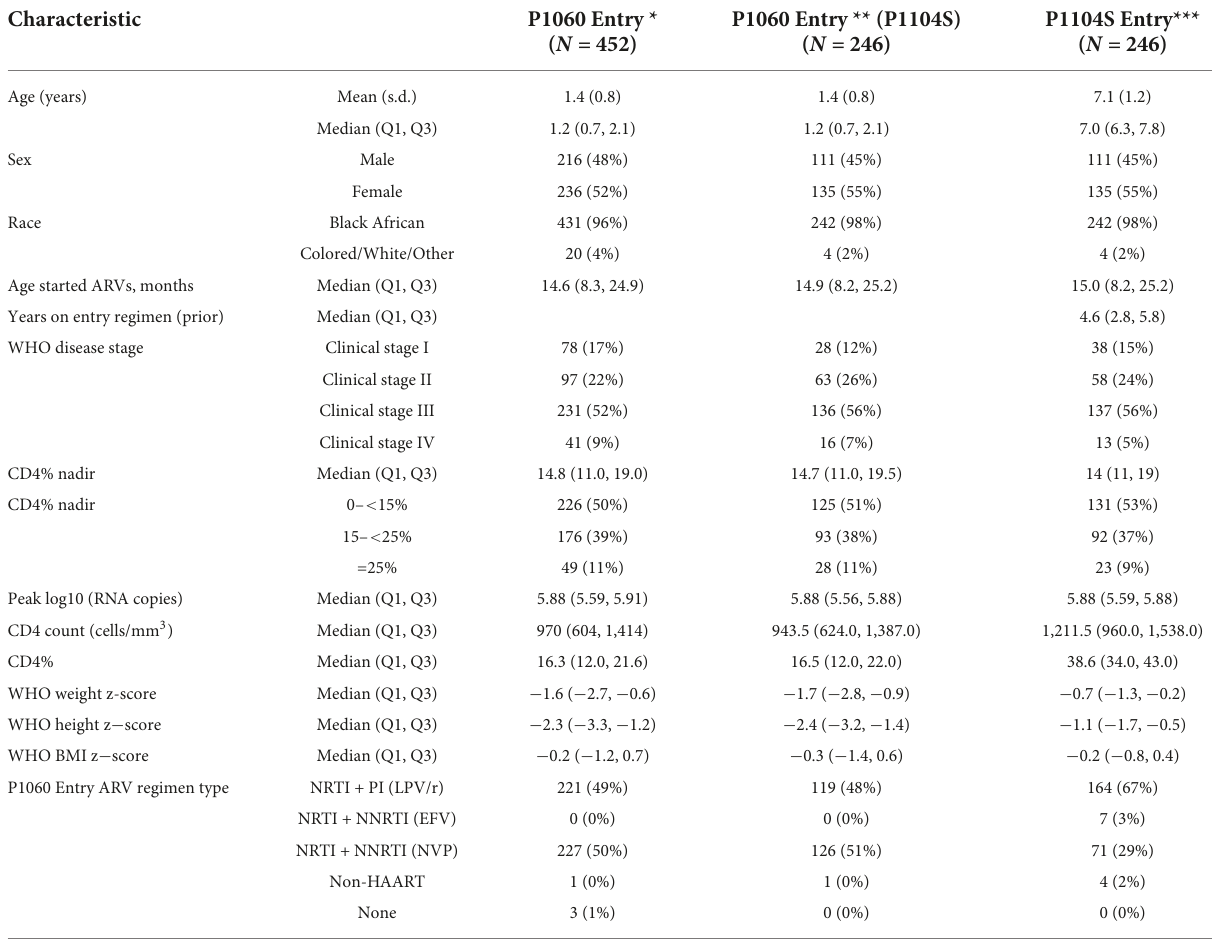
TABLE 1 Child characteristics at entry to P1060 and